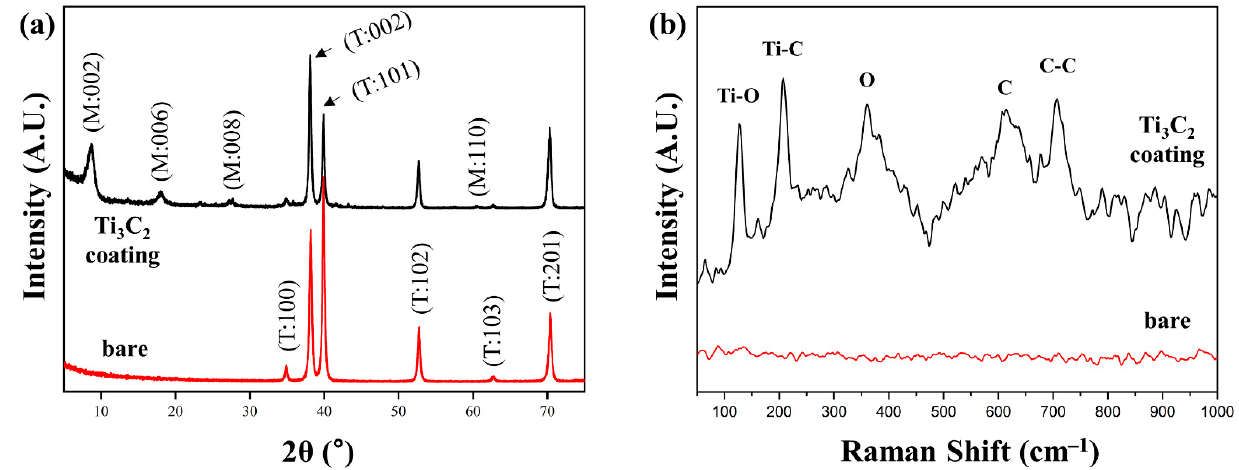
Figure 2. ( a ) XRD patterns (T: Ti, M: Ti 3 C 2 ) and ( b ) Raman spectra of bare and Ti 3 C 2 -coated Ti.